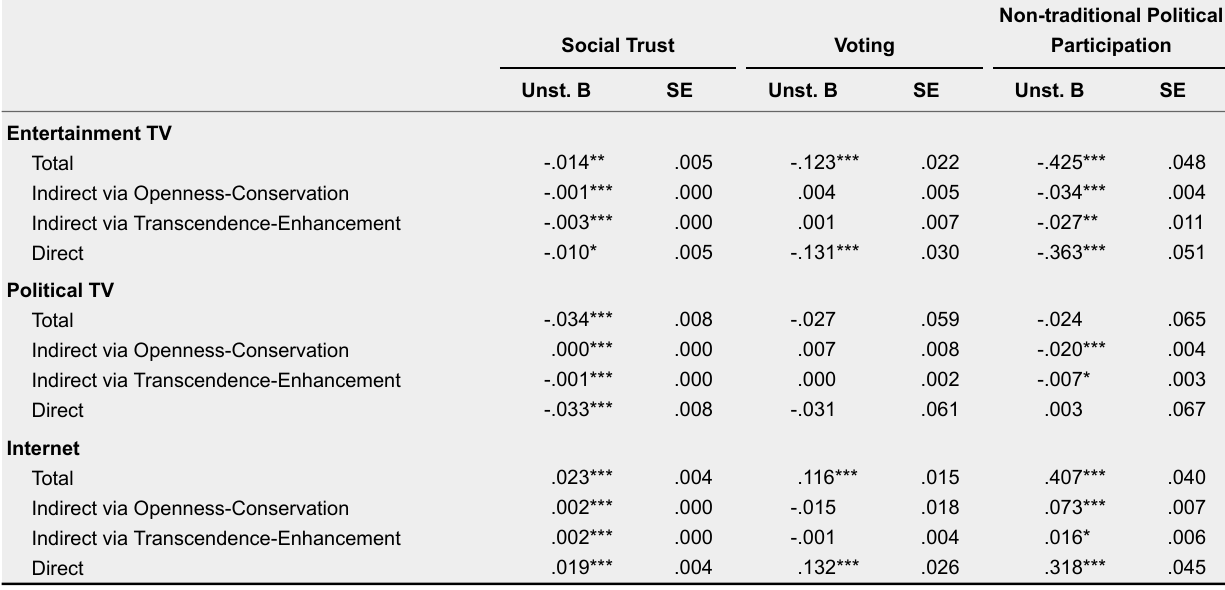
Direct, Indirect, and Total Effects of Media Usage (N = 37,704)